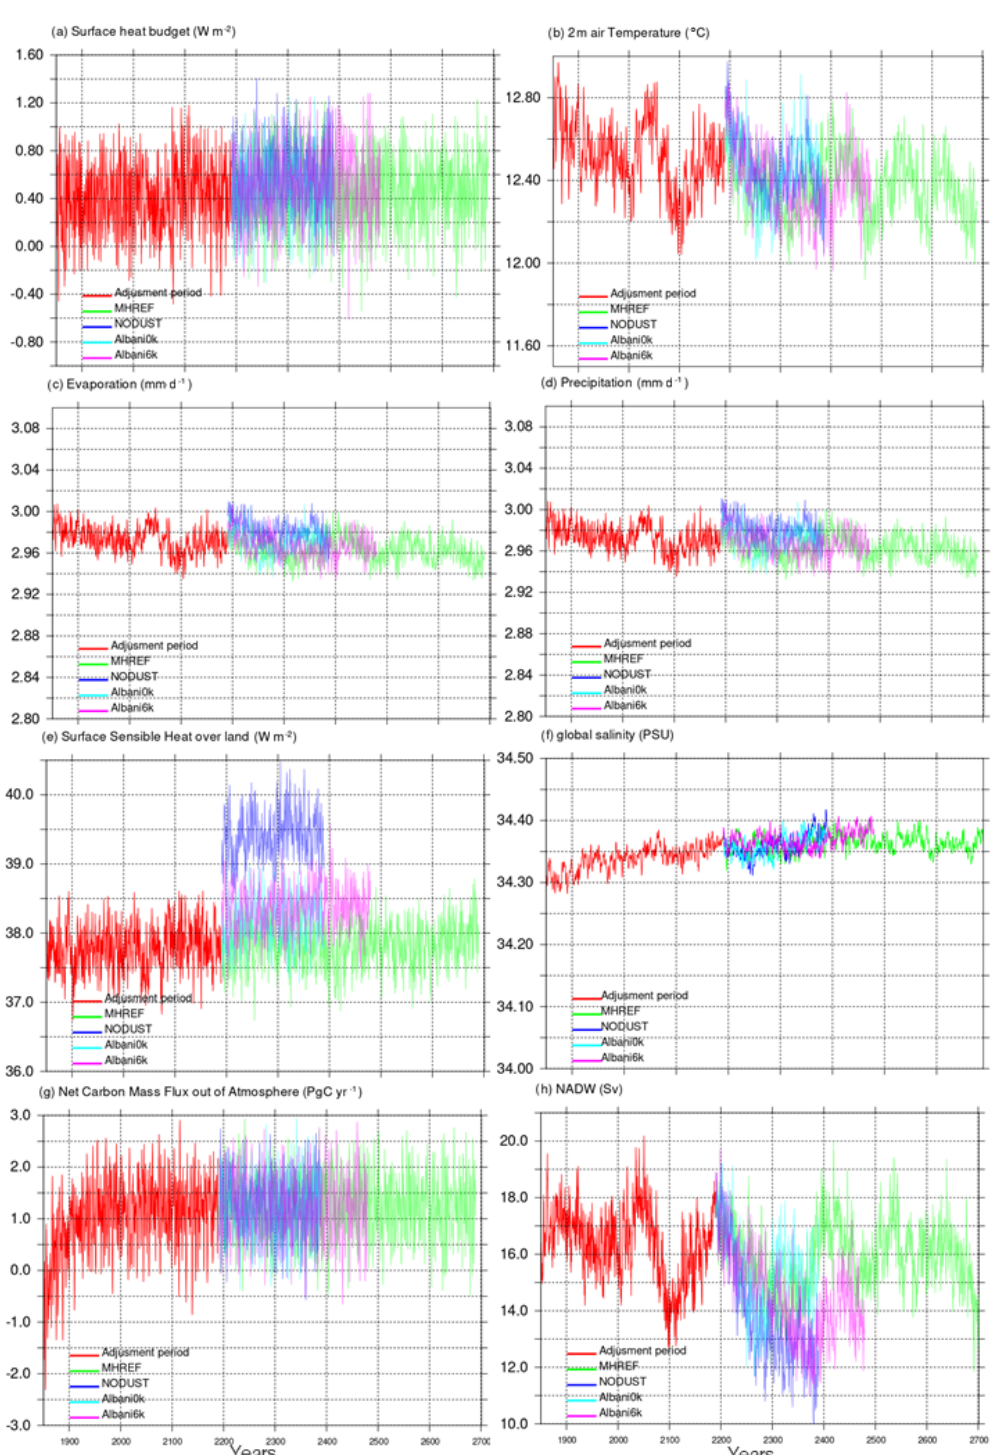
Figure 1. Temporal evolution of a subset of atmosphere, ocean and land surface variables for the different simulations: (a) surface heat budget (Wm − 2 ), (b) 2m air temperature ( ◦ C), (c) evaporation (mmd − 1 ), (d) precipitation (mmd − 1 ), (e) surface sensible heat over land (Wm − 2 ), (f) global salinity (PSU), (g) net ecosystem productivity (PgCyr − 1 ) and (h) maximum overturning in the North Atlantic (Sv). In each plot, the red curve represents the adjustment phase from the pre-industrial condition when the mid-Holocene forcing (Earth’s orbit and trace gases) is switched on. The green curve corresponds to the reference mid-Holocene simulation (MHREF), whereas the other curves stand for the different sensitivity tests to dust forcing, starting from the same initial state as the reference mid-Holocene (MHREF) simulation (Table